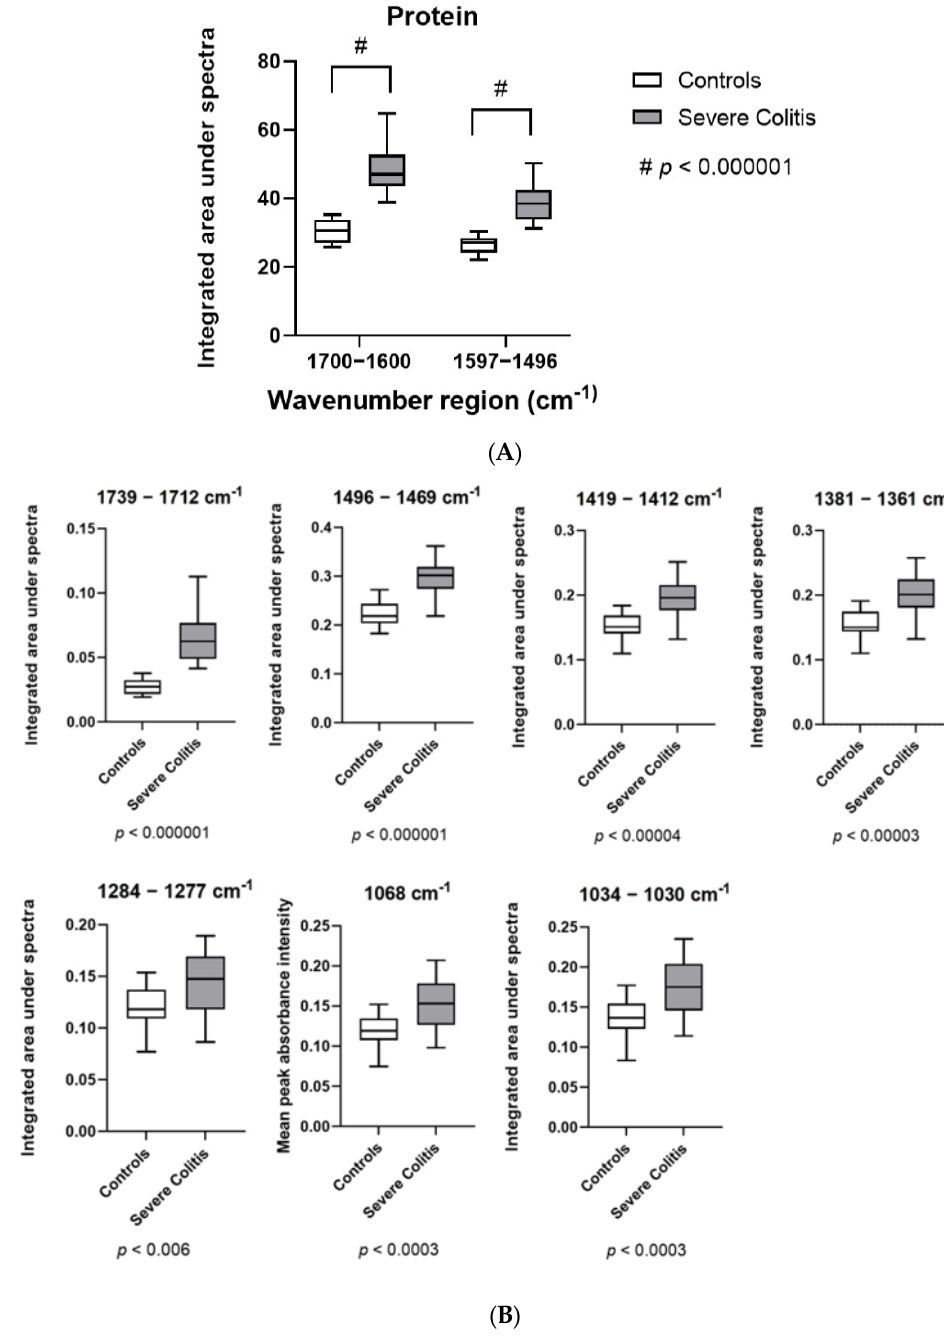
Figure 6. Significant VIP scores correlating to the PLS-DA classification model for healthy tissue and severe colitis from Figure 5. ( A ) Significant VIP scores representing amide I and II protein bands. ( B ) Other significant VIP scores, including those for glycoproteins and nucleic acids.